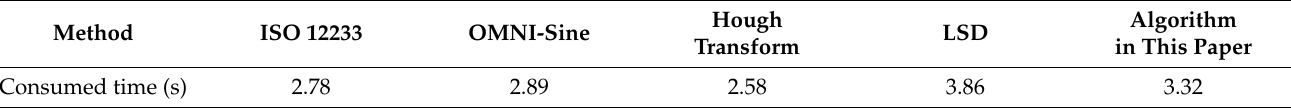
Table 6. Running time of different